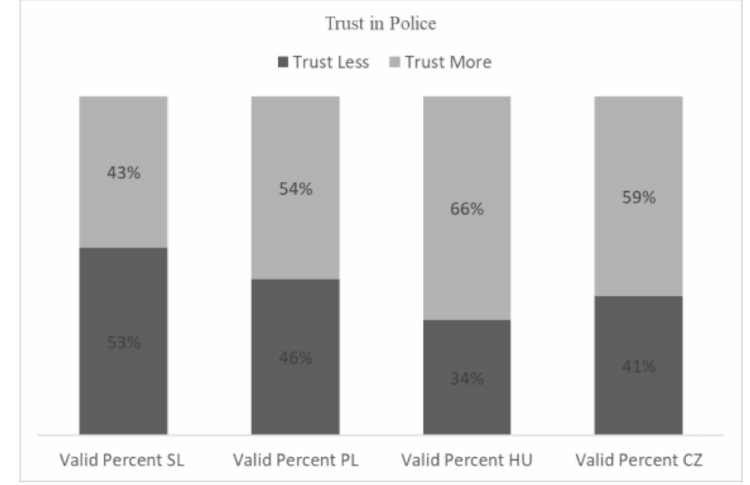
Figure 5. Responses regarding trust in the police.